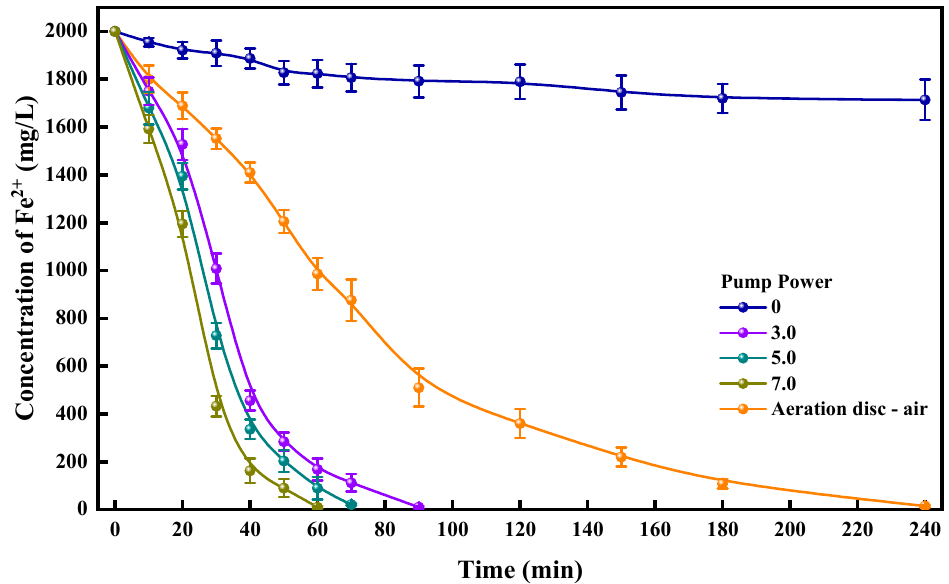
Figure 2. Influence of different powers on oxidation of ferrous ion.